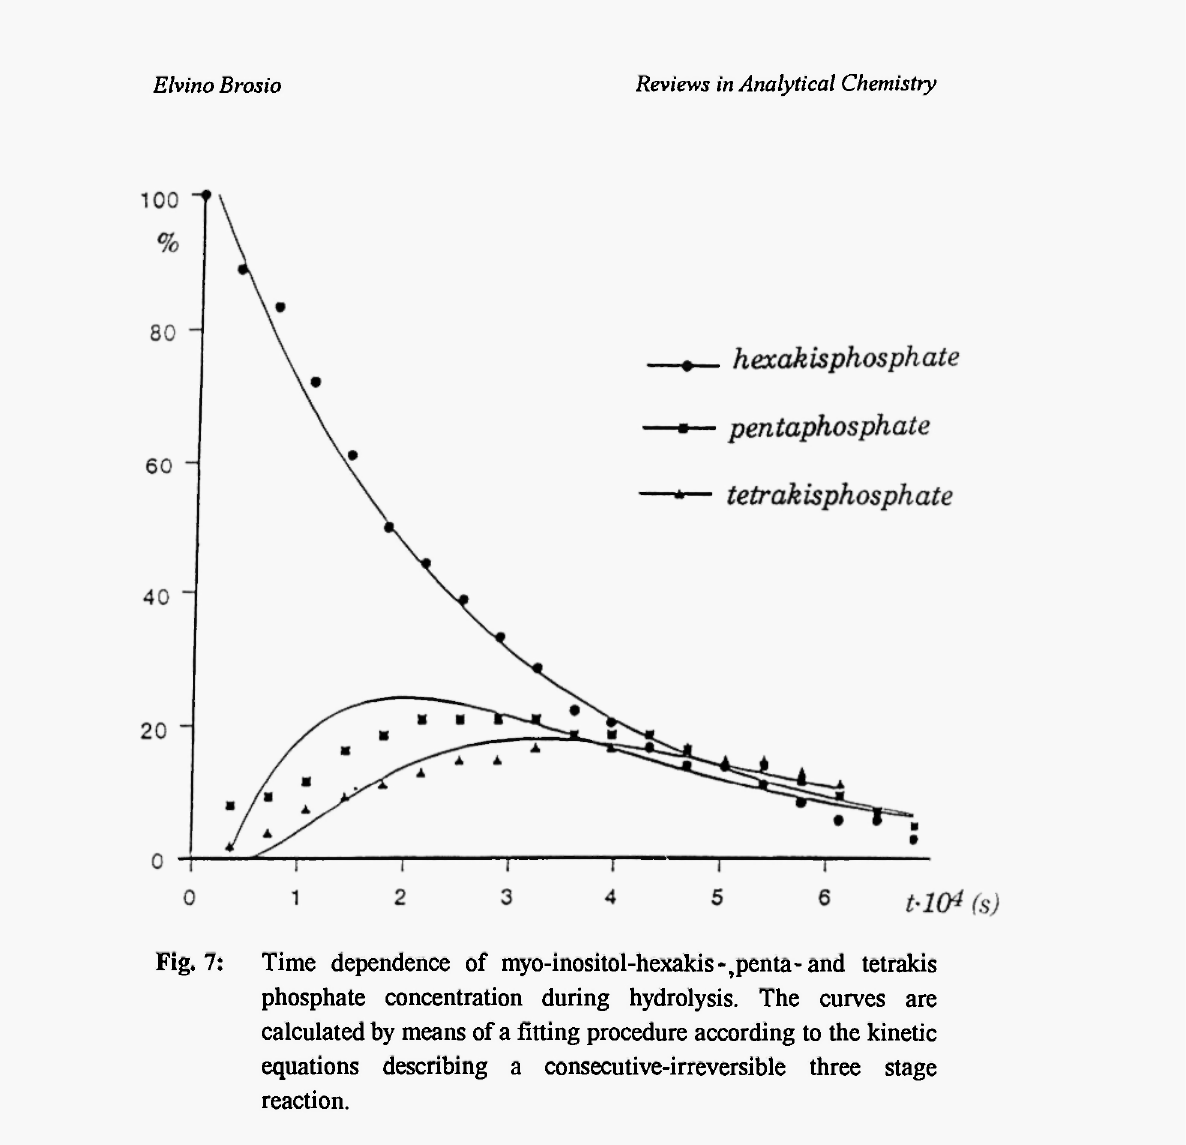
Fig. 7: Time dependence of myo-inositol-hexakis-,penta- and tetrakis phosphate concentration during hydrolysis. The curves are calculated by means of a fitting procedure according to the kinetic equations describing a consecutive-irreversible three stage